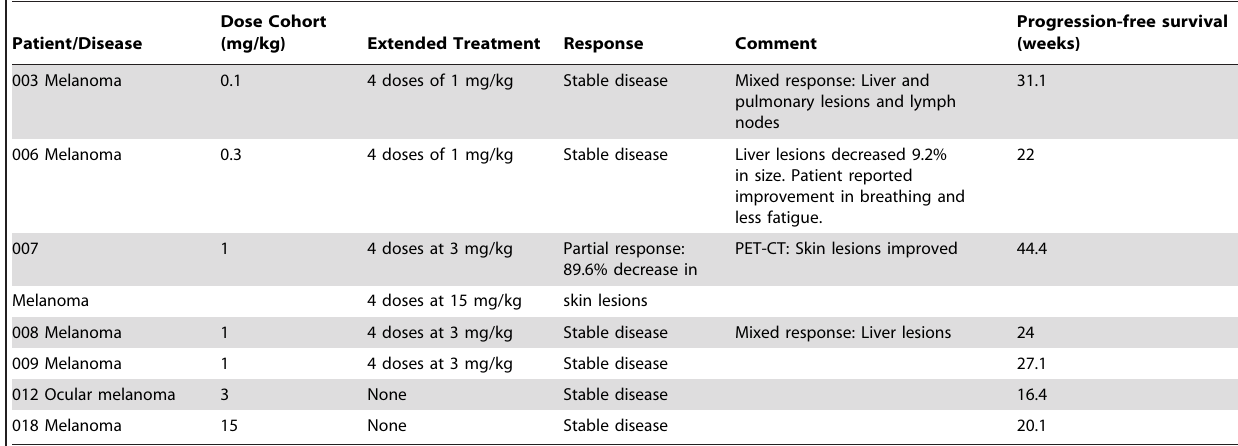
Table 3. Patient